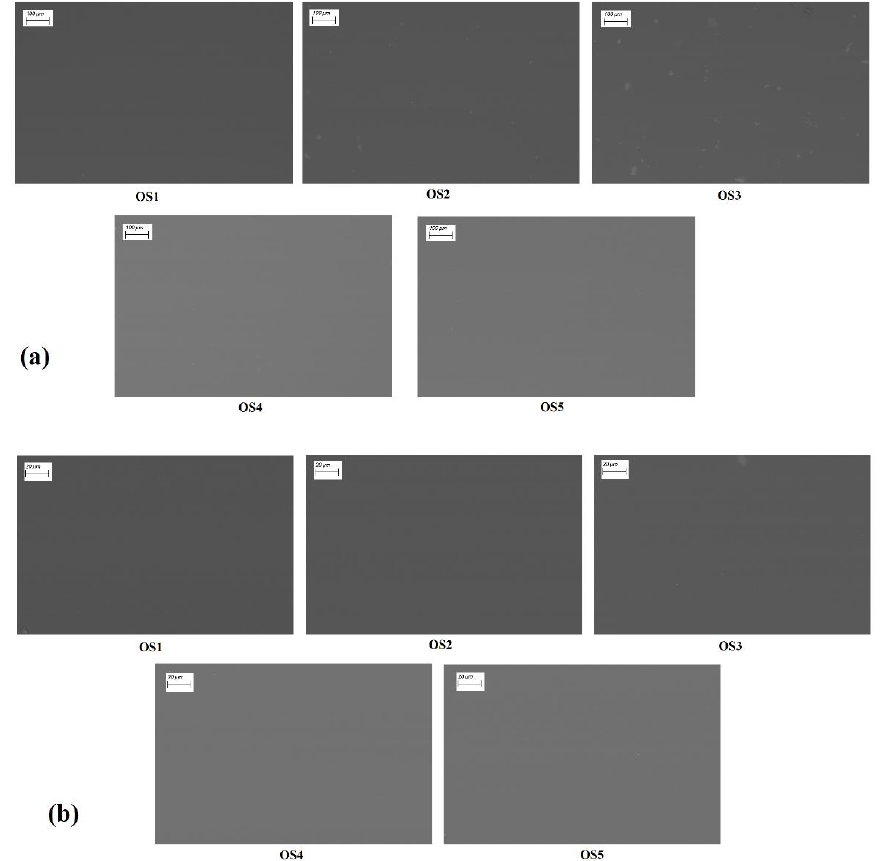
Figure 3. SEM micrographs of MnPcCl – chalcone films at ( a ) 250× and ( b )